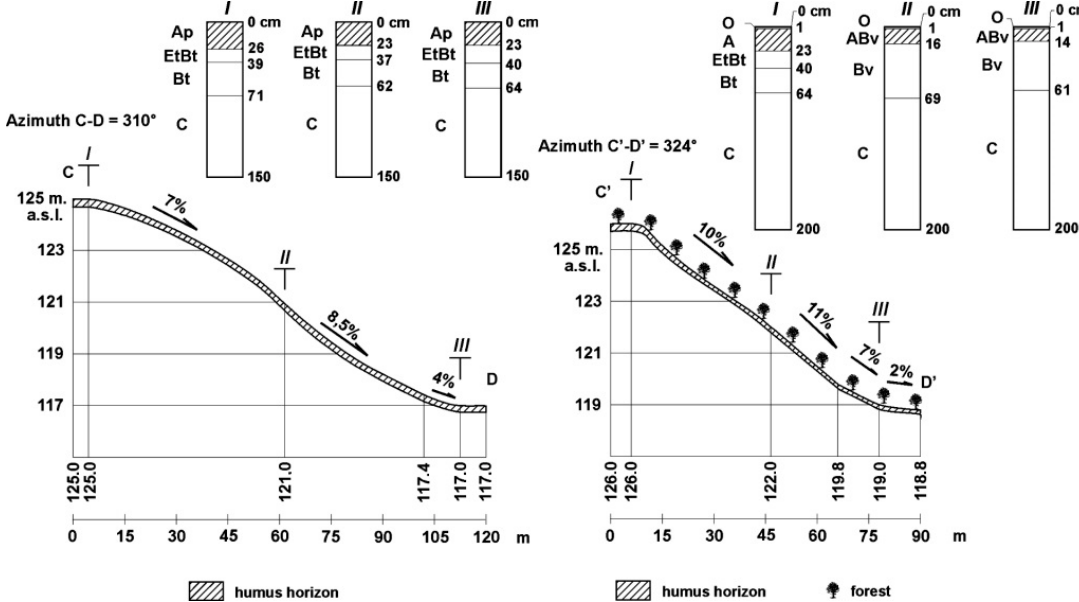
Figure 2. The soil cross sections C-D and C’-D’. Slope gradient in %; A: humus horizon; E: eluvial horizon; B: enrichment horizon; C: parent material (substratum); O: organic horizon; p : plow layer; t (for E horizons): leaching of clay fraction; t (for B horizons): illuvial accumulation of clay; v: occurrence of plinthite [39].